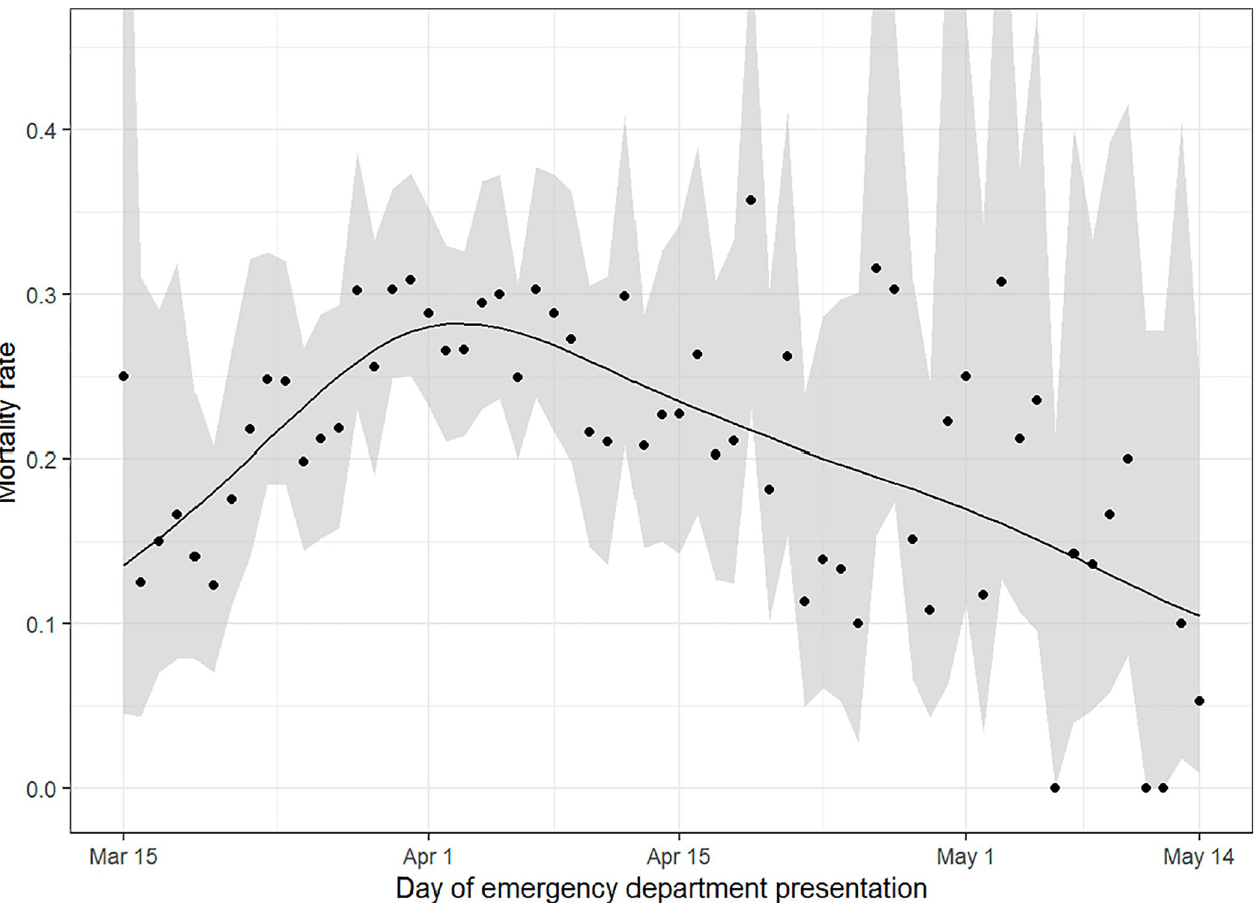
Fig 3. Proportion of hospitalized patients with COVID-19 who died in the hospital over time. Davies’ test for logistic regression shows that the increase then decrease in the mortality proportion over time is statistically significant ( P < 10 − 10 ).